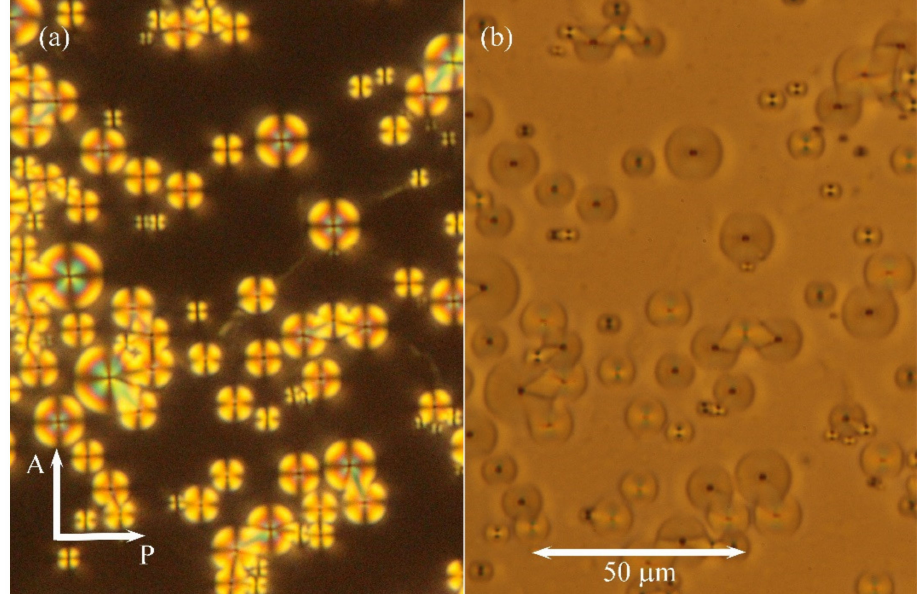
Figure 3. Texture of small focal conics and small prismatic dislocation loops in the studied hybrid composite system: ( a ) in the crossed position of the analyser (A) and the polariser (P) and ( b ) in depolarised light. The width of the picture is 120 µ m. Clusters of nanoparticles are visualised as black dots accompanied by line defects, either focal lines or dislocation